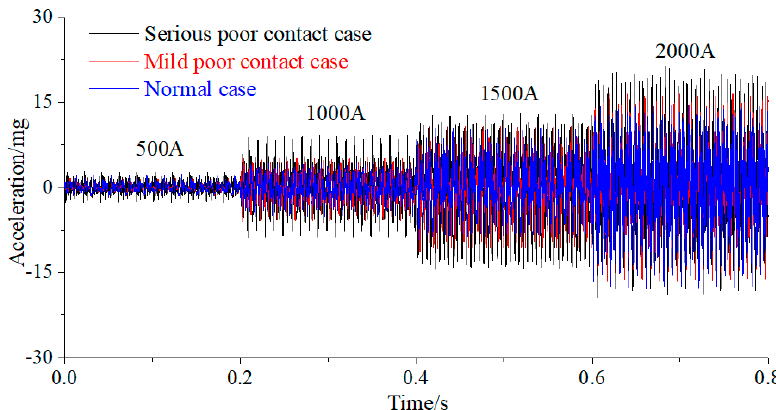
Figure 10. Time - domain waveform under different case.